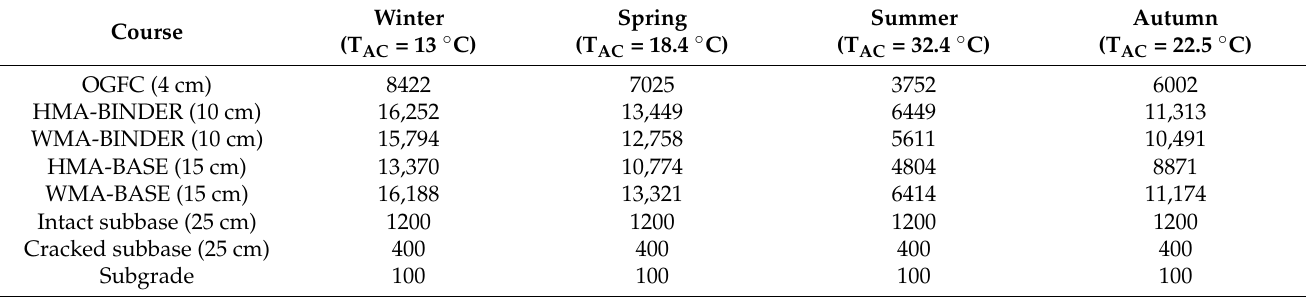
Table 2. Stiffness moduli considered in the KENPAVE simulations (values in